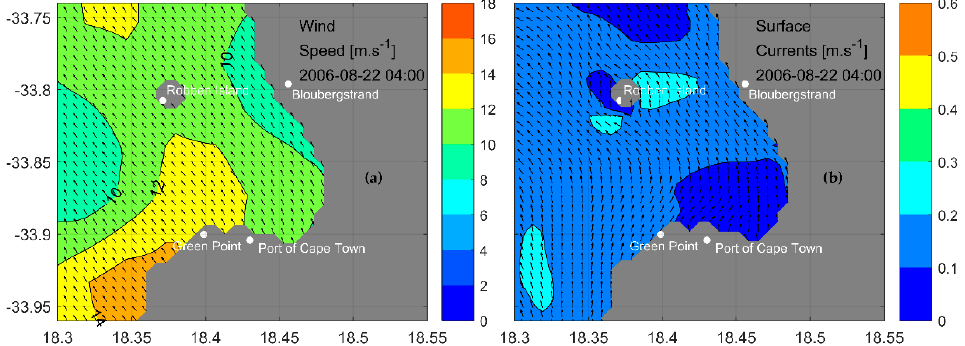
Figure 8. Closer inspection of surface currents ( b ) in Table Bay during a south-easterly wind event ( a ). Within False Bay, cyclonic flow is produced in response to south-easterly winds.